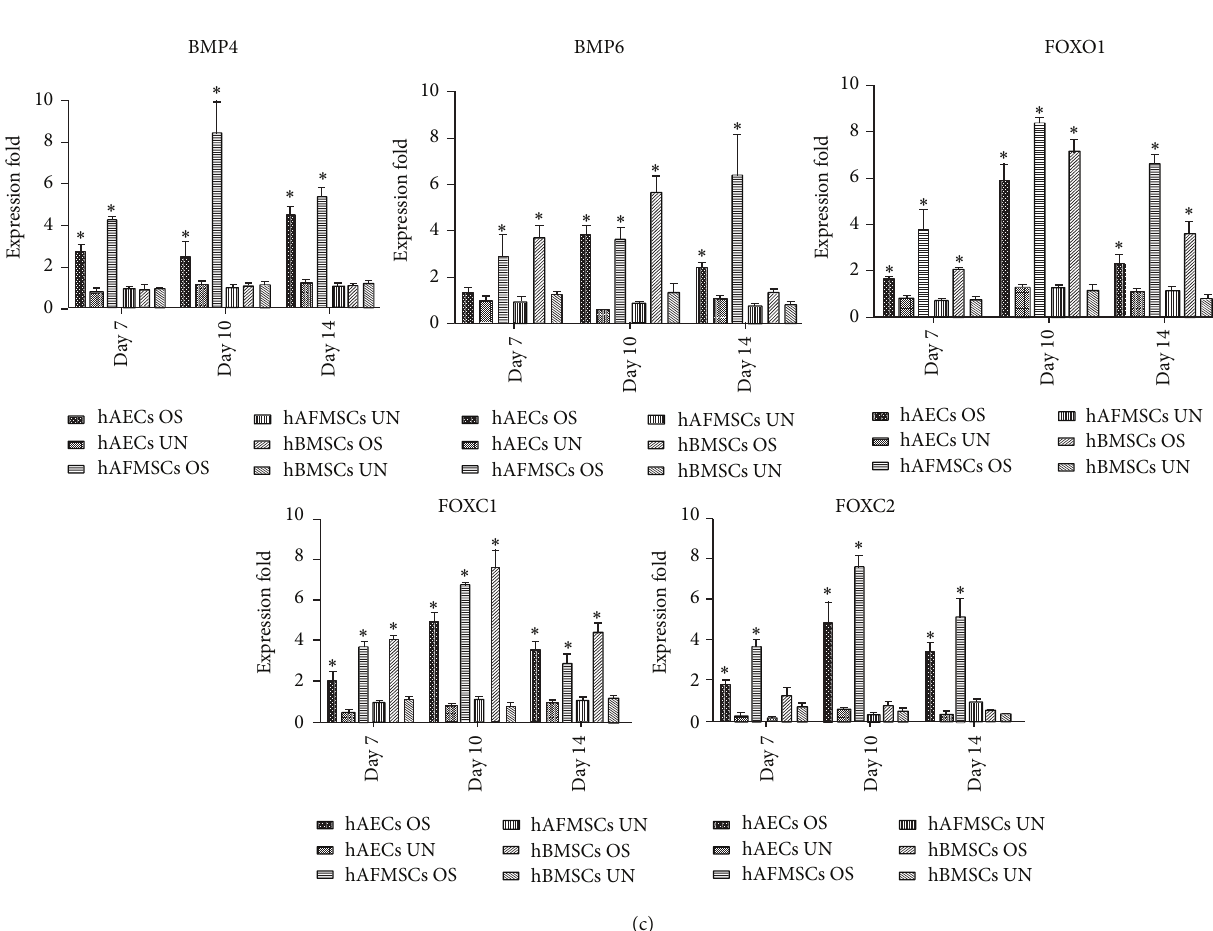
in all experimental groups compared with the control group, indicating the osteogenic potential of all three cell